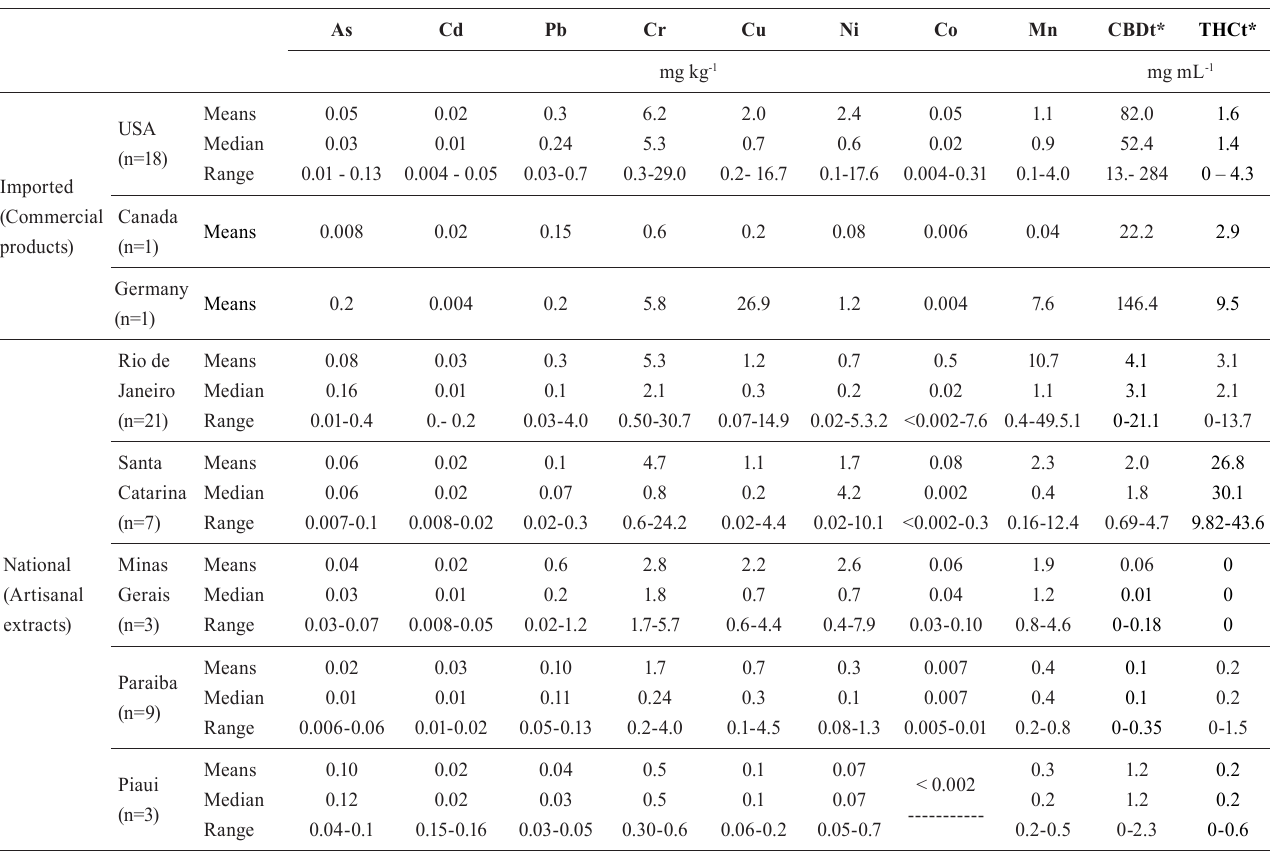
TABLE III – Concentration, median and range of inorganic elements and cannabinoids in medicinal Cannabis extracts consumed by pediatric patients in